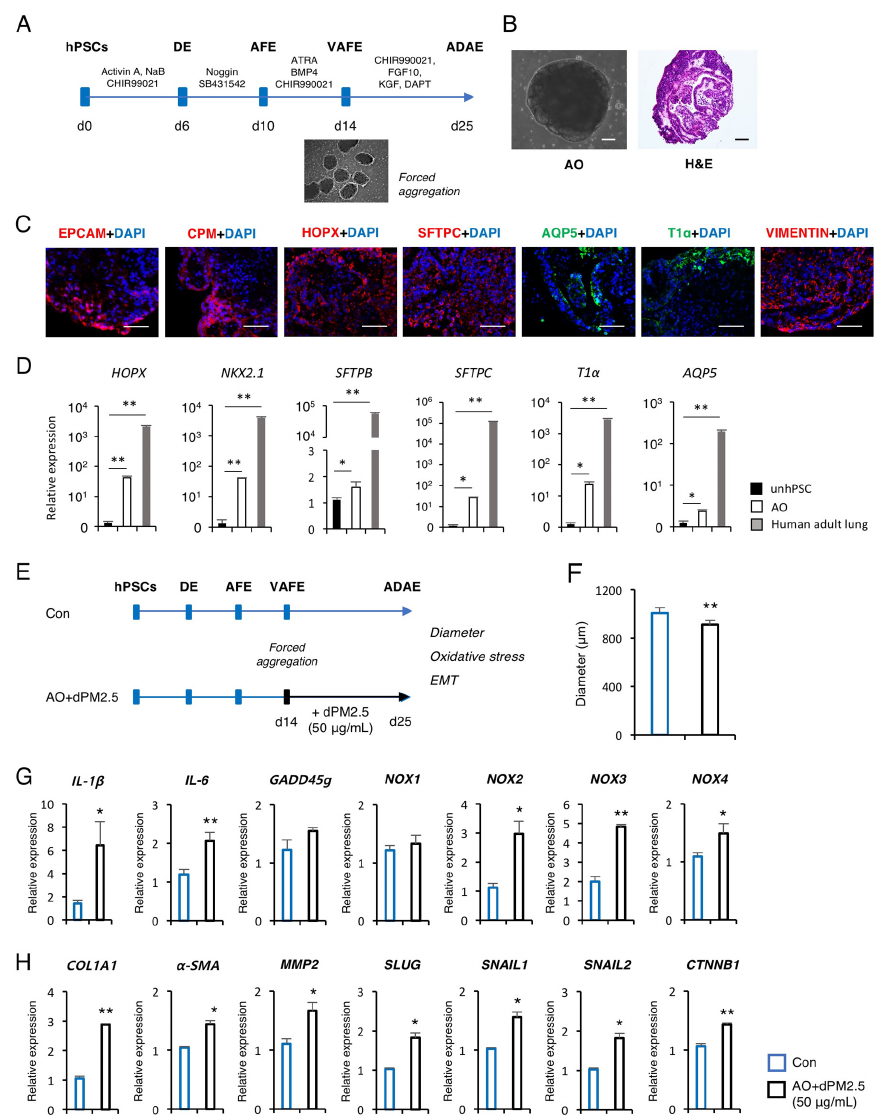
Figure 4. Effects of dPM2.5 exposure during hPSC-derived alveolar organoid (AO) development. ( A ) Figure 4. E ff ects of dPM2.5 exposure during hPSC-derived alveolar organoid (AO) Schematic diagram of AO generation from hPSCs. ( B ) Representative bright field and H&E staining images of AOs. Scale bars, 100 μ m. ( C ) Immunofluorescence staining for AEP (EPCAM, CPM, and HOPX, red), AEC1 (AQP5 and T1 α , green), AEC2 (SFTPC, red) and mesenchymal stromal cell (VIMENTIN, red) markers in AOs on day 25 of induction. Nuclei were counterstained with 4 ′ ,6- diamidino-2-phenylindole (DAPI) (blue). Scale bars, 100 μ m. ( D ) qPCR analysis of the indicated AEP and AEC markers in AOs. Data are shown as fold-change relative to undifferentiated hPSCs (unhPSC). Data is presented as mean ± SD. * p < 0.05, ** p < 0.01. ( E ) Schematic diagram of dPM2.5 treatment during hPSC-derived AO development. Black lines indicate the duration of dPM2.5 treatment. Scale bars, 100 μ m. ( F ) Measurement of AO size was taken by averaging the longest and